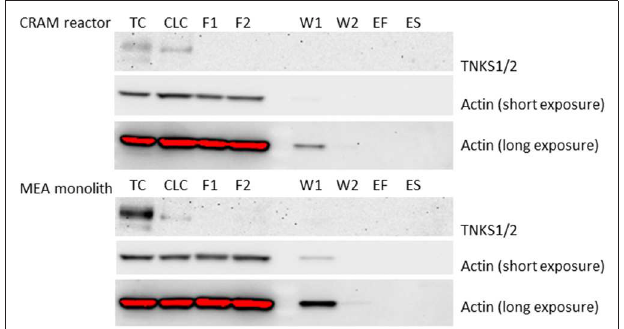
FIGURE 3 | Western blot of: (TC–Tankyrase Control) lane of 21 µ g of protein from 007-LK control and (CLC–Cell lysate control) lane of 36.3 µ g of protein from cell lysate of HEK293. Samples collected from the CRAM reactor (Upper) and MEA monolith (Lower) in the following lanes: (F1) Flush of 36.3 µ g protein from cell lysate of HEK293, (F2) Flush of 36.3 µ g protein from cell lysate of HEK293, (W1) Wash 1 with water, (W2) Wash 2 with water, (ES) eluted with 2% formic acid and (ES) eluted with 2% SDS. The exposure time was 7,200s for TNKS1/2, and for actin 10s (short exposure) and 180s (long exposure). The raw files from western blot are given in Supplementary material section 4 , Figure S10 .